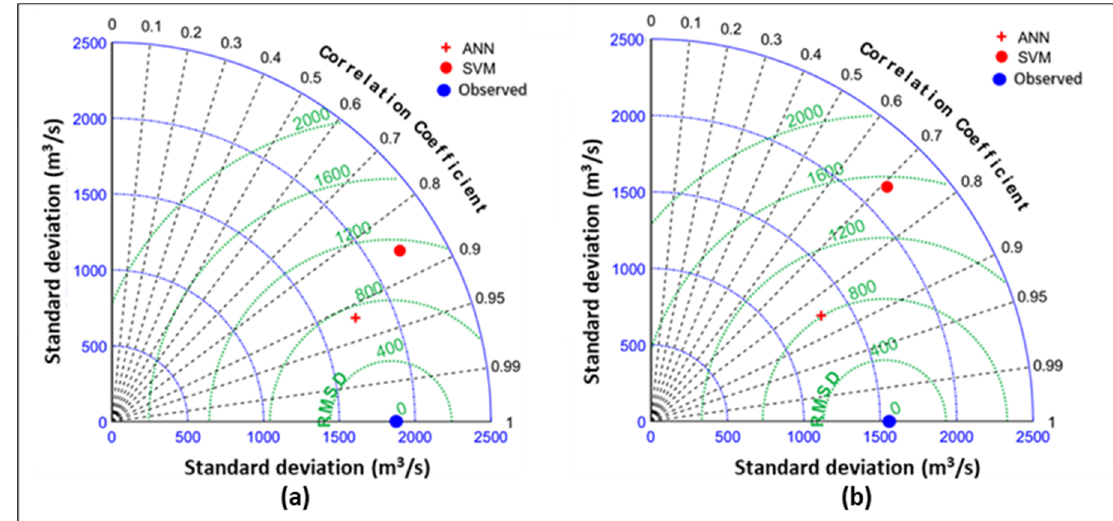
Figure 13. Taylor diagram for the ANN and SVM compared to the observed data: ( a ) training; ( b ) testing.